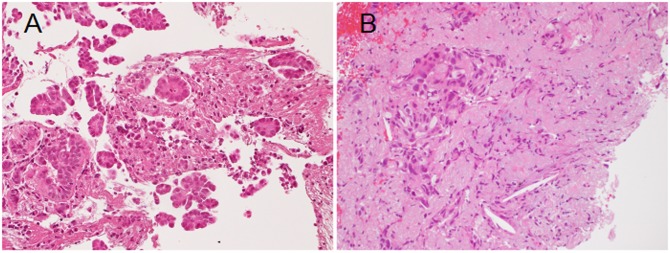
Representative histological appearances of the biopsy specimens (A, EGFR-mutated lung adenocarcinoma (LADC); B, EGFR wild-type LADC).The micropapillary element, which is composed of papillary structures lacking fibrovascular cores, floats in alveolar spaces (A, hematoxylin and eosin (HE) stain, ×200). The acinar element (and some crush artifacts) grows in collapse fibrosis (B, HE stain, ×200).